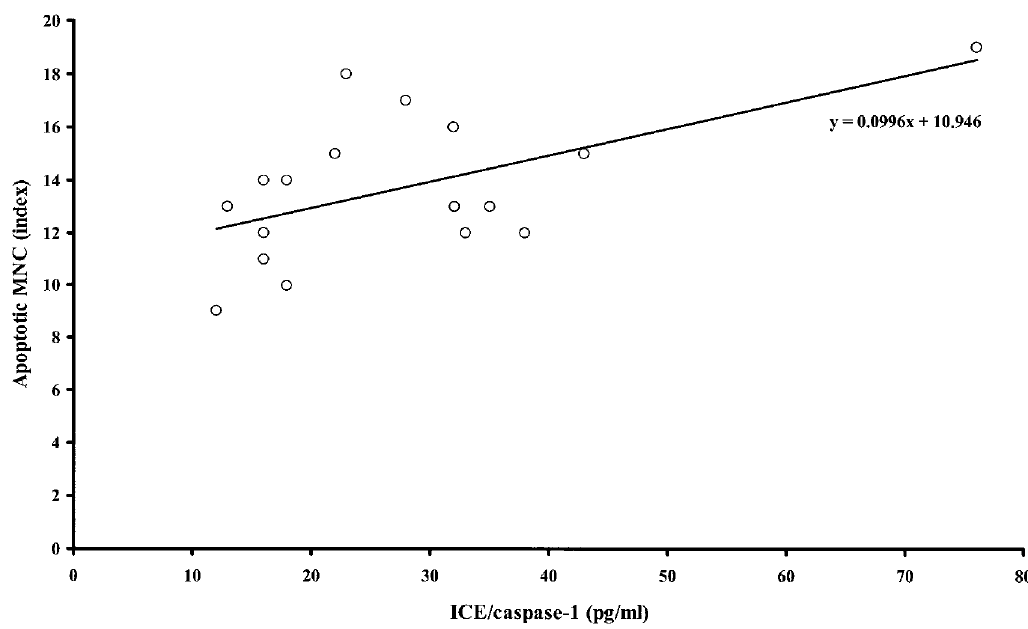
FIG. 6. Relationship between serum ICE/caspase-1 levels and T0 apoptosis of MNC in an allergic